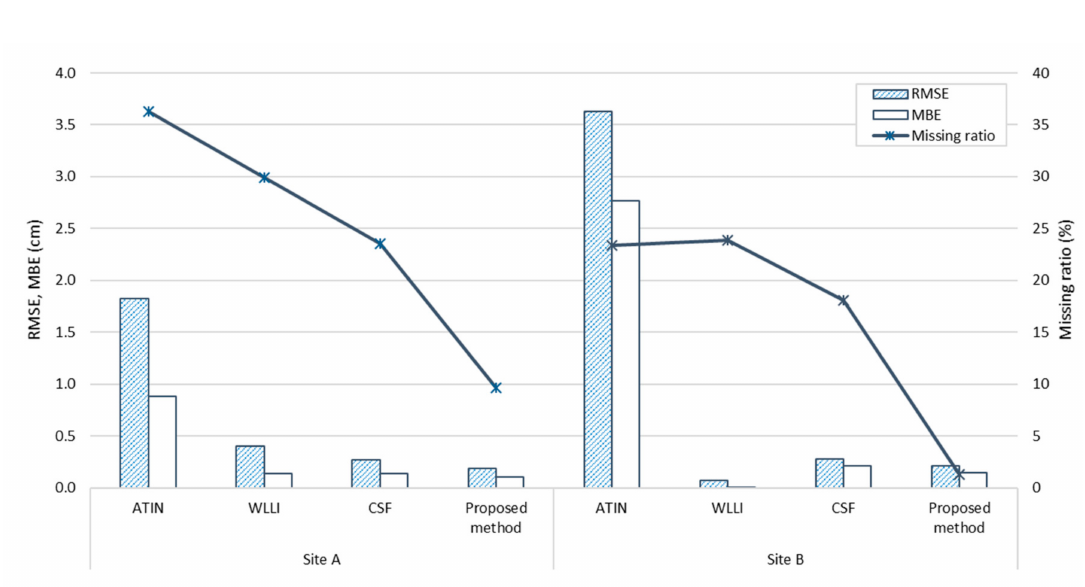
Figure 10. Plot showing filtering results from different